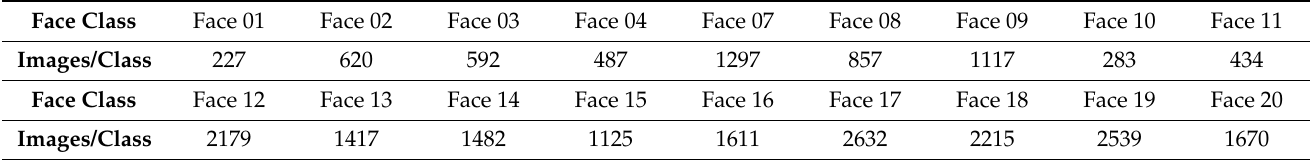
Table 2. Database image